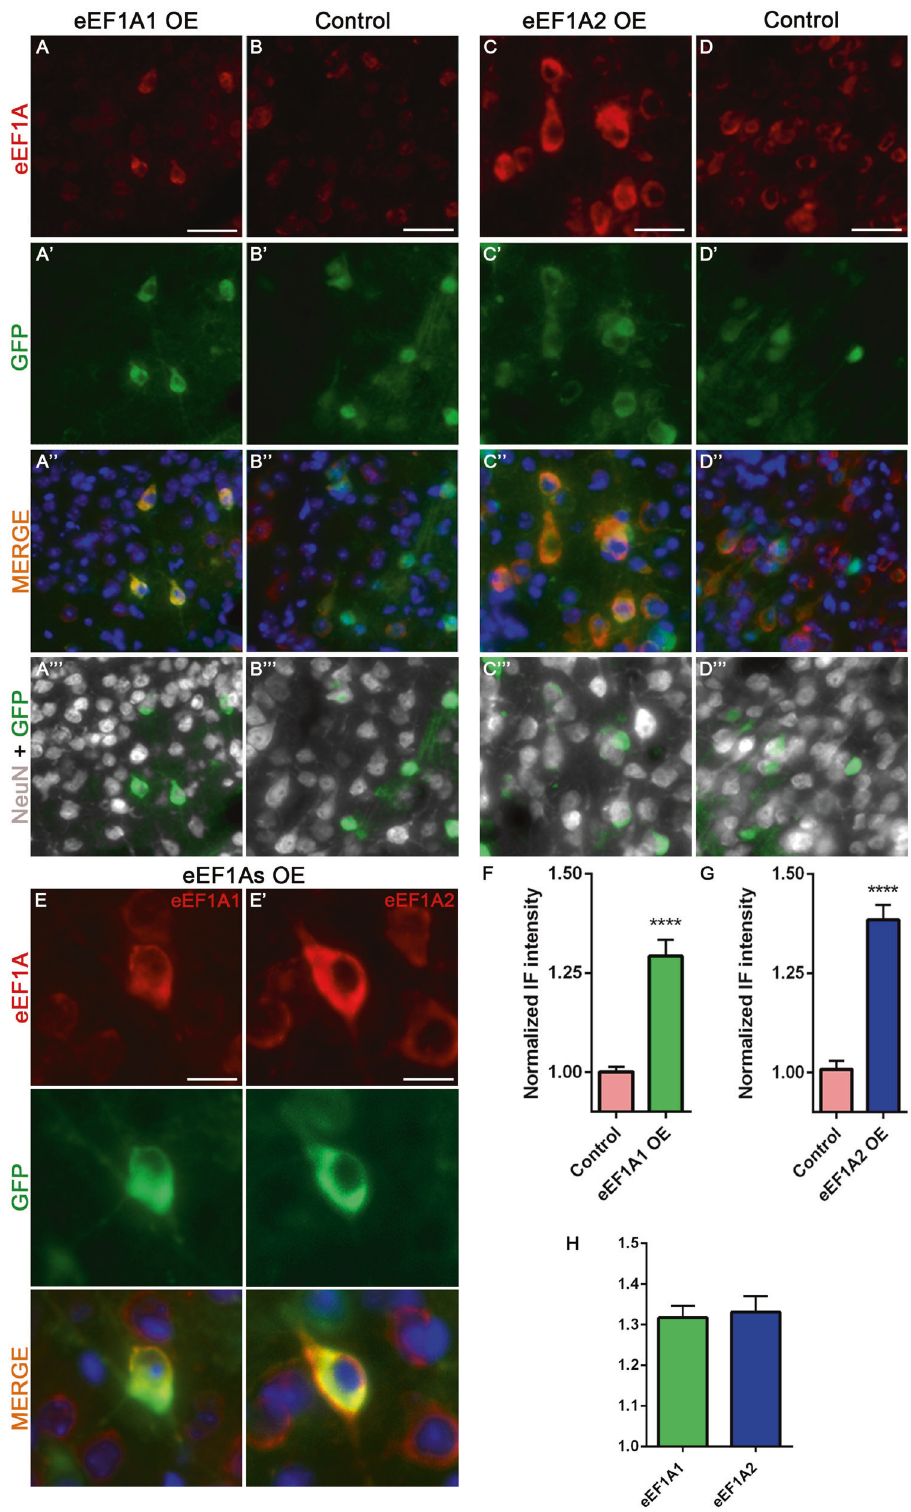
Fig. 1 Infection by AAV-eEF1A1 or AAV-eEF1A2 increases the level of eEF1A1 and eEF1A2 proteins, respectively, in CST neurons. Representative images of eEF1A1, GFP (viruses), and NeuN staining at the layer V of the right sensorimotor cortex of injured eEF1A1- overexpressing (OE) mice ( A – A ”’ ); and injured control mice (AAV-GFP injection) ( B – B ”’ ). Representative images of eEF1A2, GFP (viruses), and NeuN staining at the layer V of the right sensorimotor cortex of injured eEF1A2-OE mice ( C – C ”’ ); and injured control mice (AAV-GFP injection) ( D – D ”’ ). E , E ’ Detailed images of eEF1A1 ( E ), eEF1A2 ( E ’ ) and GFP (viruses) staining in CST neurons of injured eEF1As OE mice. F Quanti fi cation of eEF1A1 immunoreactivity in eEF1A1 OE and control mice. G Quanti fi cation of eEF1A2 immunoreactivity in eEF1A2 OE and control